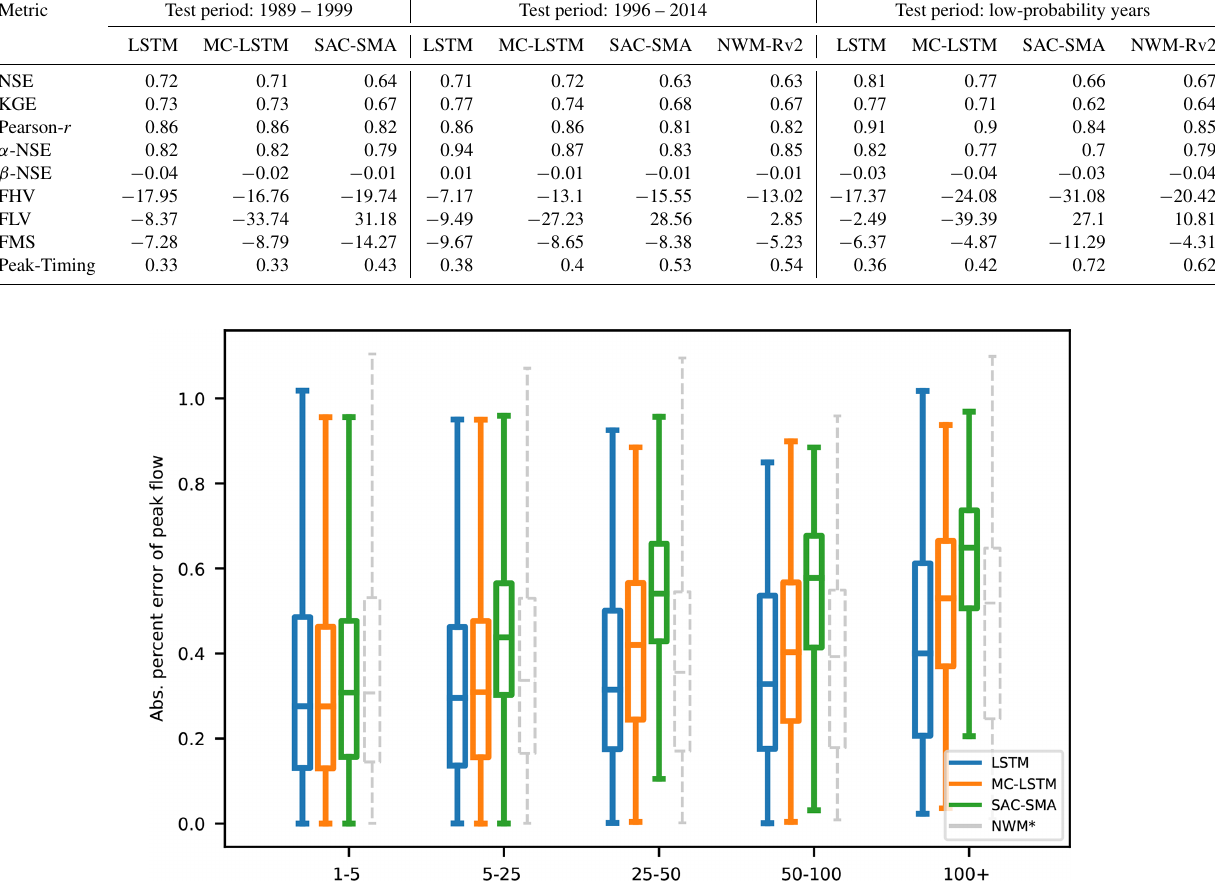
Table 2. Median performance metrics across 498 basins for two separate time split test periods and a test period split by the return period (or probability) of the annual peak flow event (i.e., testing across years with a peak annual event above a 5-year return period, or a 20% probability of annual exceedance).